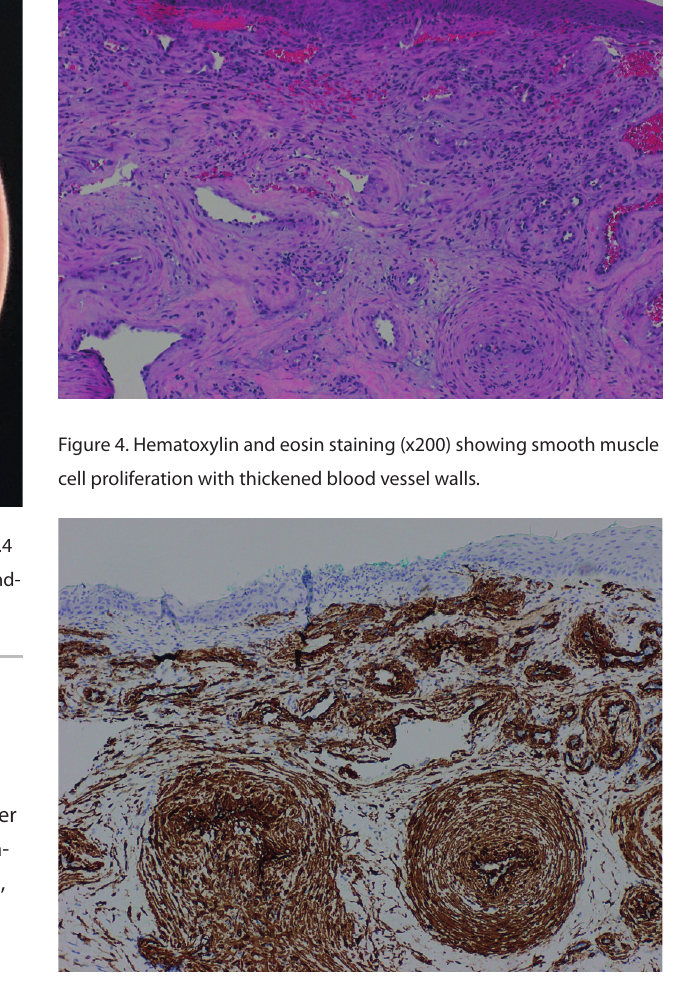
Figure 5. Histopathologic image showing positive immunostaining for alpha smooth muscle